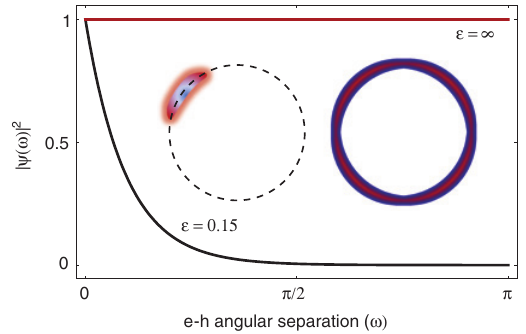
Figure 1: Wavefunction of 3D excitons calculated in spherical coordinates on the surface of a 4D hypersphere (glome) [45]. In the plot, ω is the angular separation between the electron and the hole, with ω ≈ 0 for Frenkel excitons and, on the opposite limit, delocalised over the whole space for ε = ∞ . The radius of the glome is normalised to 1 for simplicity in both cases and it is related (inversely proportional) to the dielectric constant of the material and the reduced mass of the exciton. In the inset, pictorial representations of the 2D cross-sections of the Frenkel and Wannier–Mott wavefunctions on the glome are